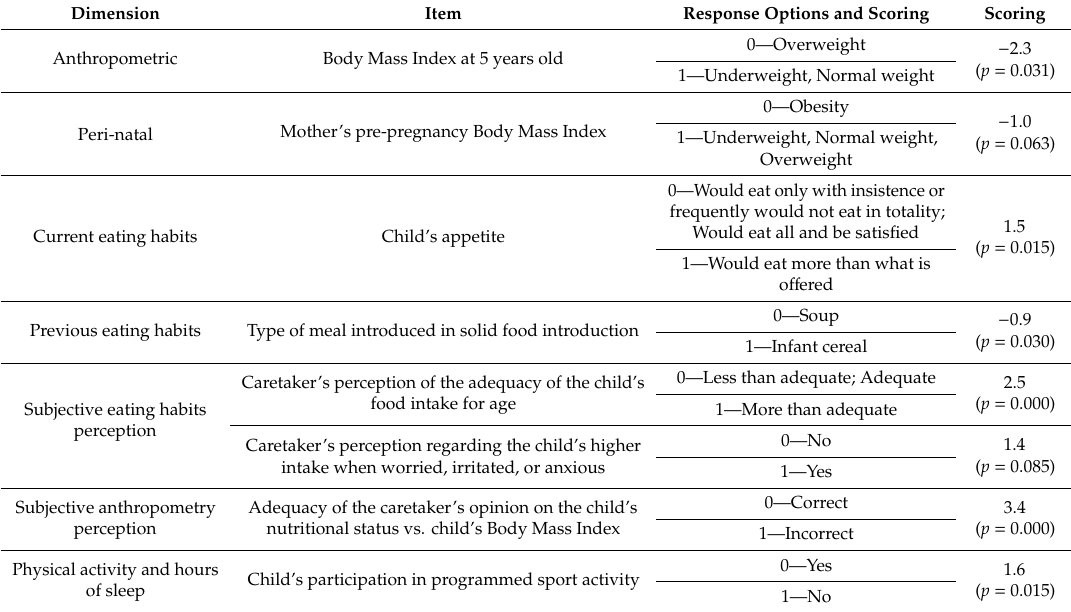
Table 4. Items included in the Risk of childhood Obesity in the Community (RisObIn.Com) tool, categorization, and